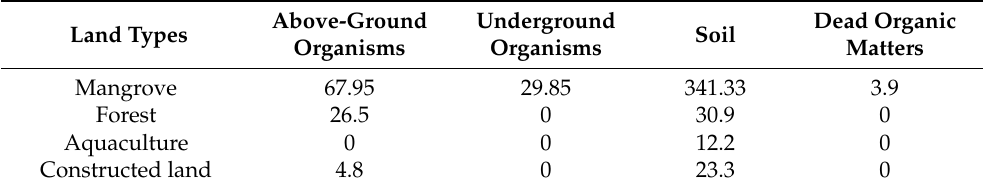
Table 2. Carbon densities of different land use types (t/hm 2